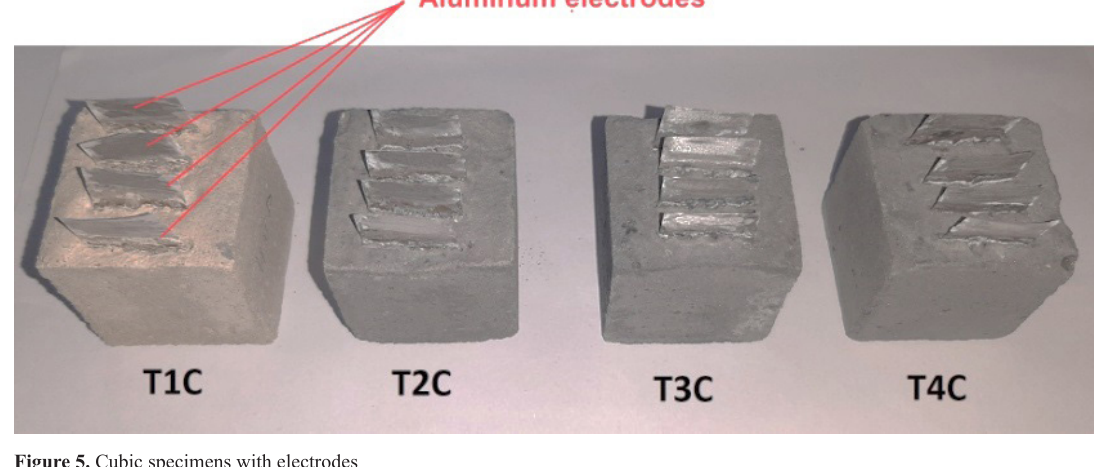
Figure 5. Cubic specimens with electrodes